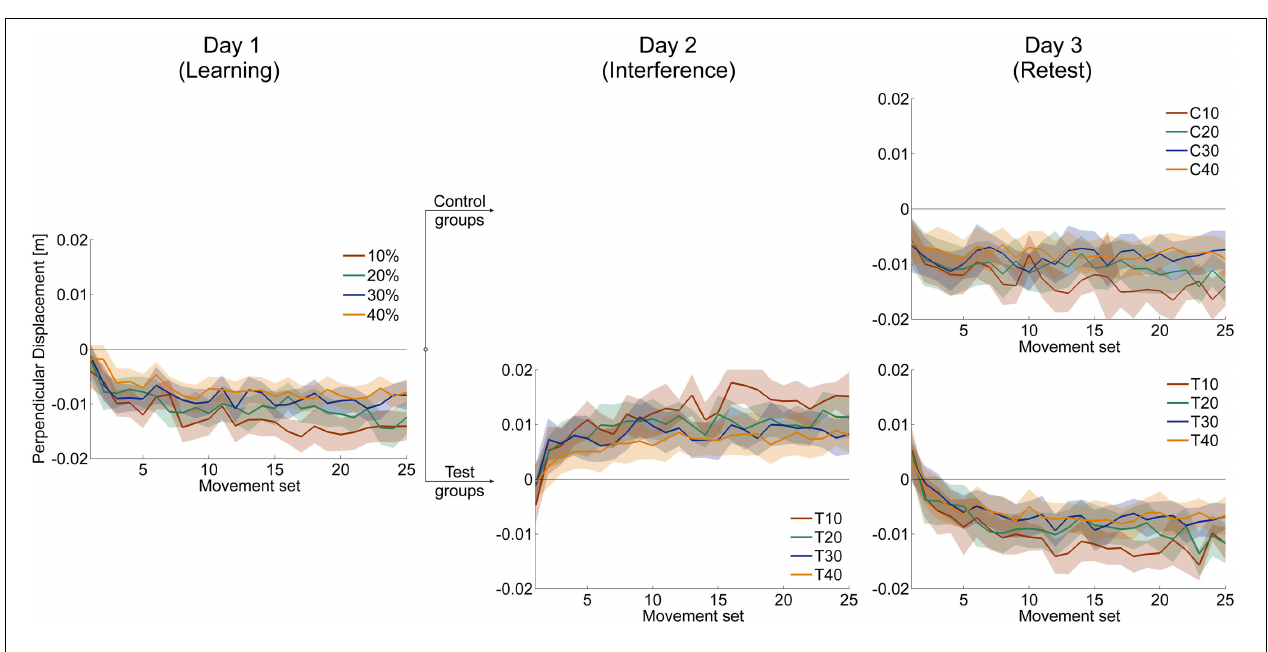
FIGURE 5 | Mean time courses of after-effects measured by signed perpendicular displacement during catch trials. Negative (positive) values indicate deviations in counterclockwise (clockwise) direction and therefore after-effects appropriate to force field A